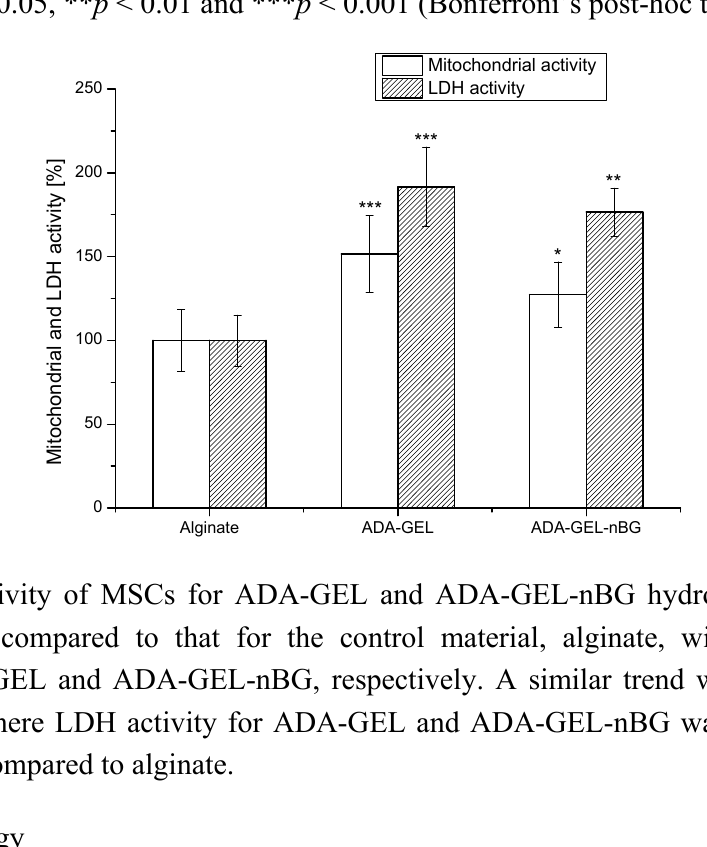
Figure 2. Mitochondrial and LDH activities of rMSCs on alginate, ADA-GEL and ADA-GEL-nBG hydrogel films after 48 h of cultivation. Alginate was used as the control material for each assay. Asterisks denote significant difference compared to alginate hydrogel, * p < 0.05, ** p < 0.01 and *** p < 0.001 (Bonferroni’s post-hoc test was